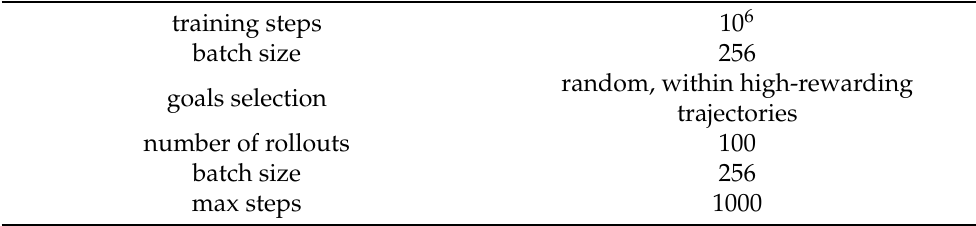
Table 6. Main controlling parameters for offline